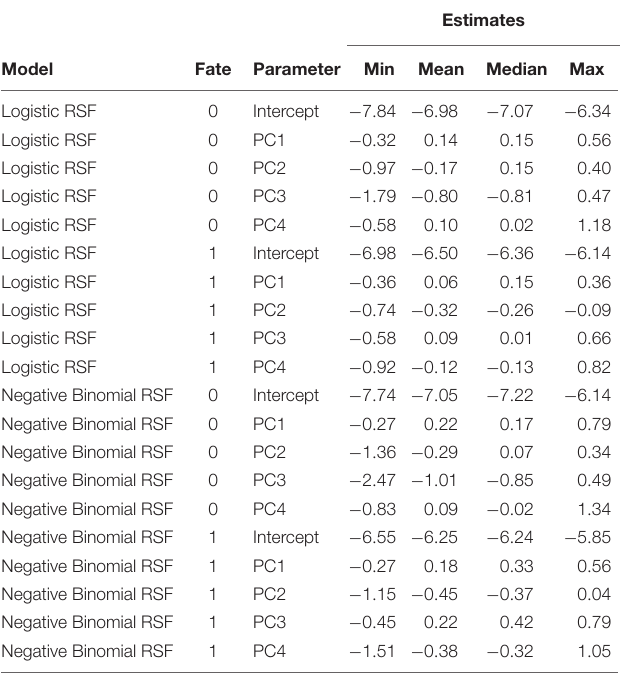
TABLE 6 | Resource selection function (RSF) coefficients for both a logistic and negative binomial model for female moose ( Alces alces ; n = 10) with calves that survived ( n = 5, fate = 1) and those with calves that perished ( n = 5, fate = 0) in northeastern Vermont, United